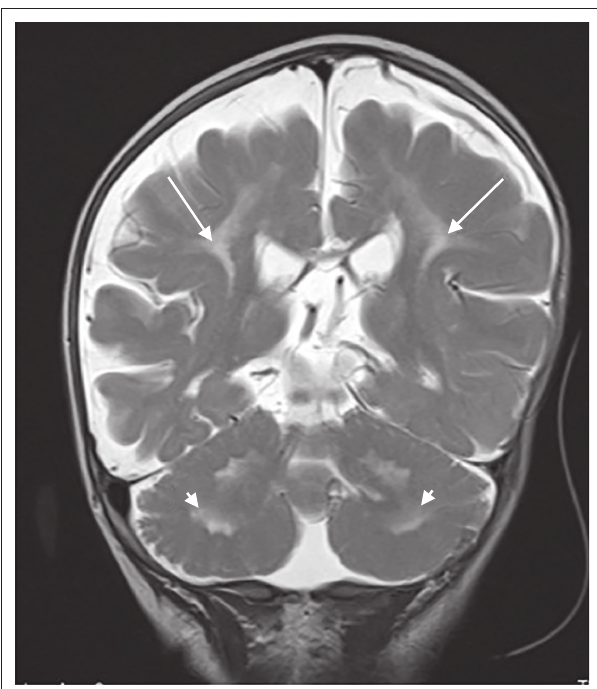
FIGURE 2: T2 coronal image of patient 1. White matter hyperintensities of the corona radiata (arrows) and cerebellar dentate nuclei (arrowheads), with background cerebral atrophy.